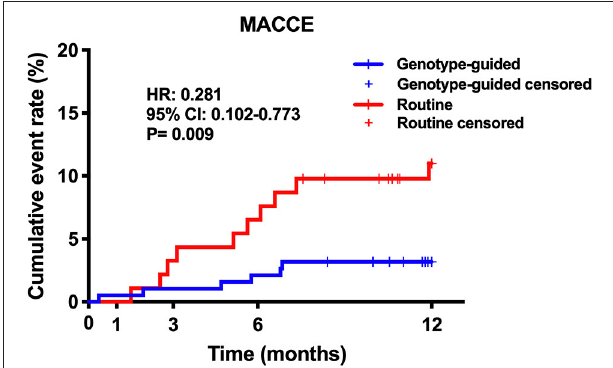
FIGURE 3 | Kaplan–Meier curve of MACCE during 12-month follow-up. MACCE, major adverse cardiovascular or cerebrovascular events.